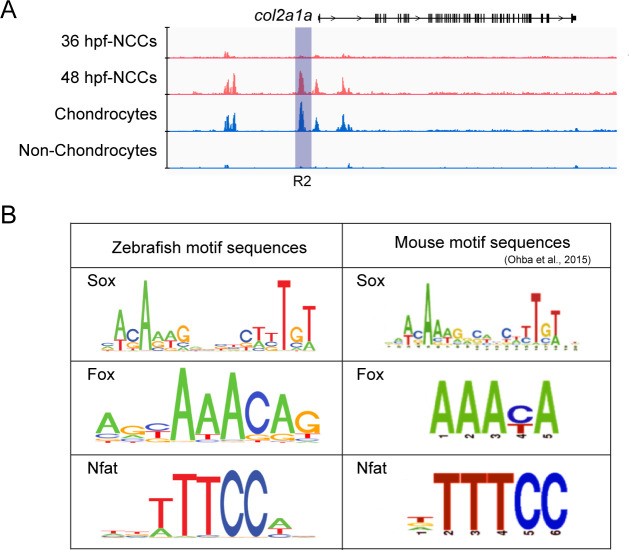
col2a1a enhancer and cartilage motif comparison between zebrafish and mouse.(A) col2a1a locus showing μATACseq reads from the indicated experiments. Several regions become accessible in 48 hpf CNCCs and then remain open in chondrocytes at 72 hpf. Boxed region shows the published R2 cartilage enhancer. (B) Comparison of consensus motif sequences recovered from zebrafish μATACseq peaks enriched in facial chondrocytes (left) and mouse Sox9 ChIP-Seq peaks in rib chondrocytes (right).